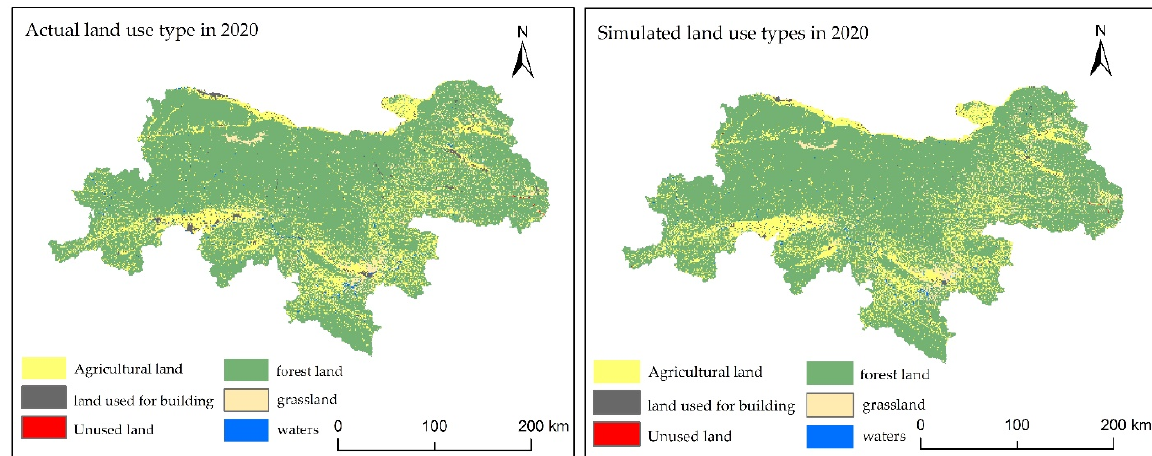
Figure 5. Spatial data set of driving factors for land-use type simulation.